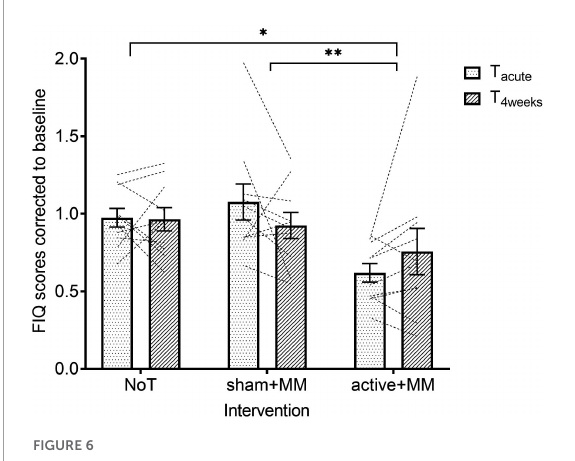
FIGURE6 Effects of combining MM and tDCS on quality of life. Graph shows how the baseline corrected mean FIQ scores change over time among the NoT, sham + MM and active + MM. Bars show standard error of mean. ∗ p < 0.05. ∗∗ p < 0.01.